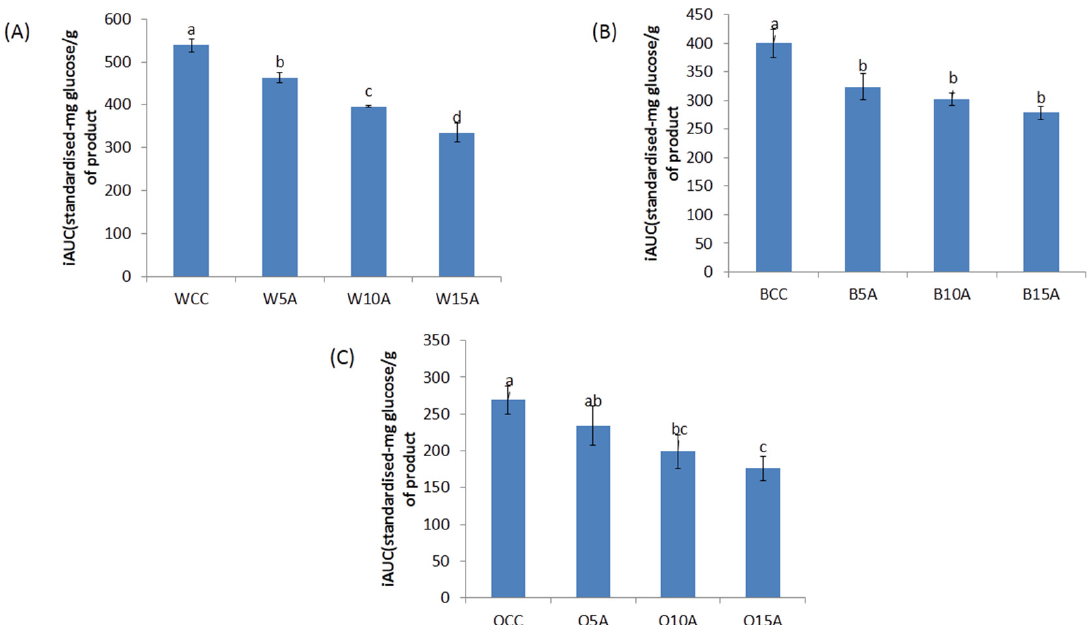
Figure 1. Reducing sugar released (mg/g sample) after 120 min digestion of ( A ) wheat, ( B ) barley and ( C ) oat wholemeal flour cookies with astaxanthin substitution. WCC, wheat cookie control; W5A, wheat + 5% astaxanthin cookie; W10A, wheat + 10% astaxanthin cookie; W15A, wheat + 5% astaxanthin cookie; BCC, barley cookie control; B5A, barley + 5% astaxanthin cookie; B10A, barley + 10% astaxanthin cookie; B15A, barley + 15% astaxanthin cookie; OCC, oat cookie control; O5A, oat + 5% astaxanthin cookie; O10A, oat + 10% astaxanthin cookie; O15A, oat + 15% astaxanthin cookie. ( a–d), Means within same figure that do not share the same superscript are significantly different ( p < 0.05).